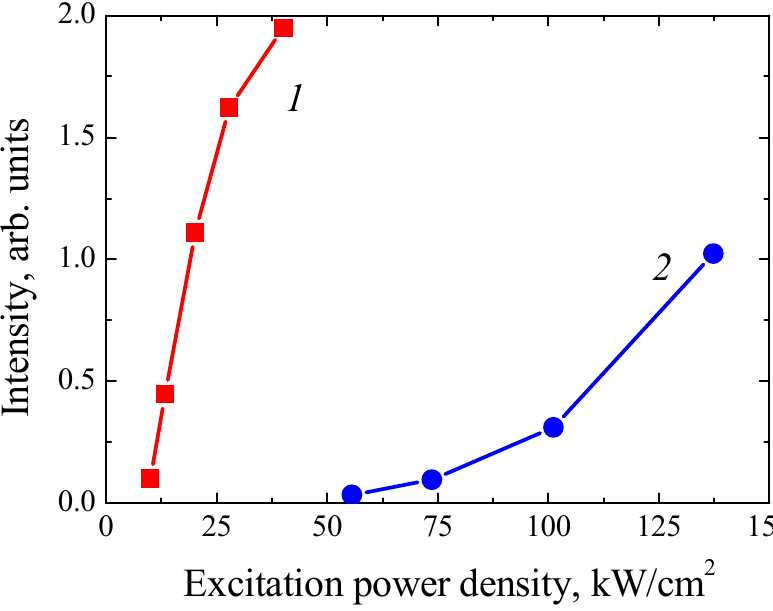
Figure 6. Dependences of the emission intensity of laser structures under the optical pumping on the excitation power density for the structures D (curve 1) and E (curve 2).